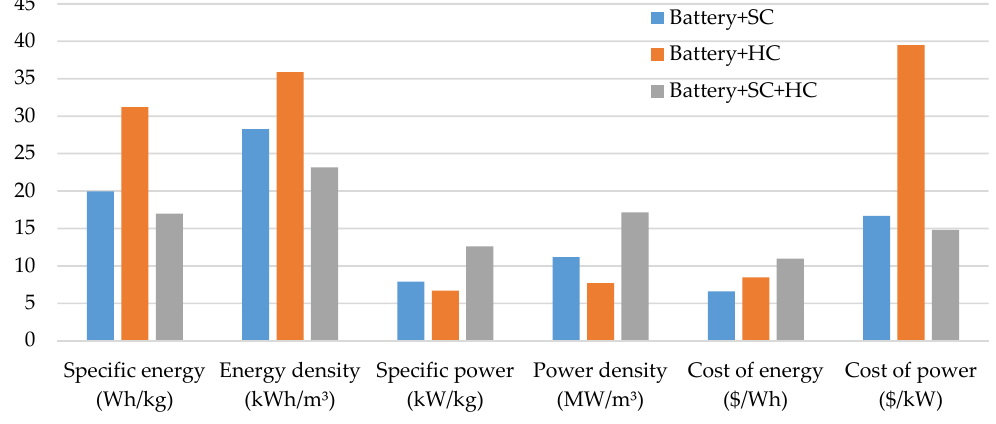
Figure 3. Normalized comparison of the normalized characteristics of the energy storage regimes.